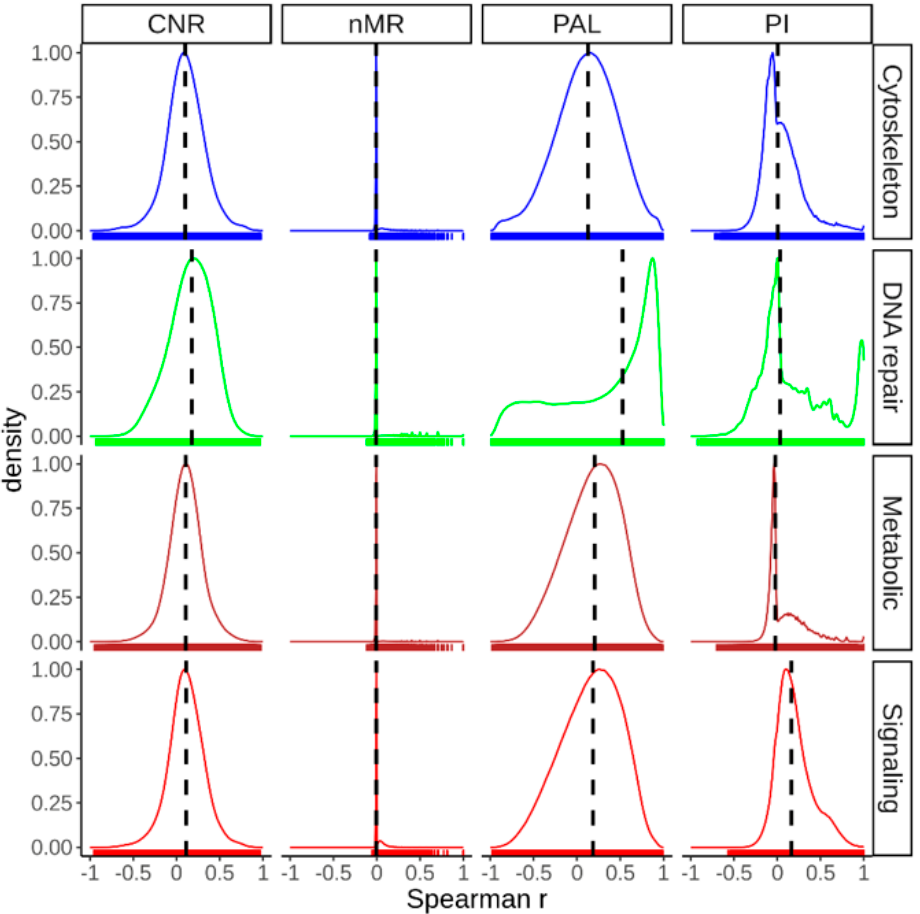
Figure 11. Distribution of pairwise Spearman correlation coefficients between all possible combinations of tumor samples under investigation for mutation and expression data at both gene wise (nMR, CNR) and pathway (PAL, PI) level in cytoskeleton, DNA repair, metabolic and signaling pathway groups. Vertical dashed lines indicate the medians of the distributions.